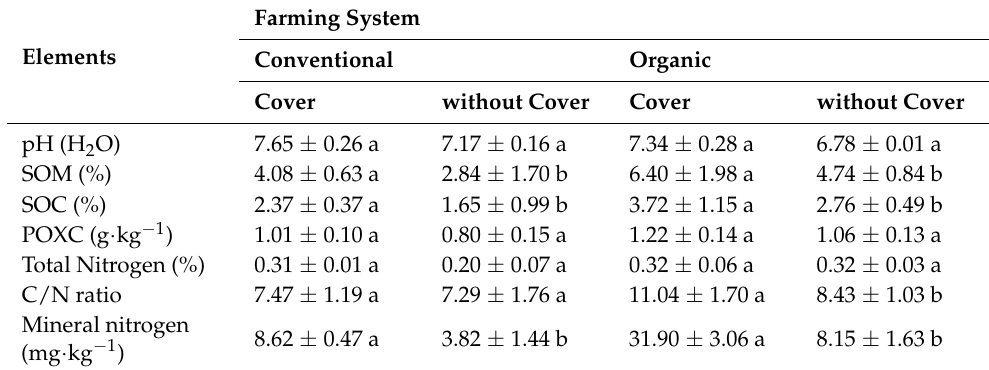
Table 1. Mean values of physicochemical parameters of soils. Farming System Elements Conventional Organic Cover without Cover